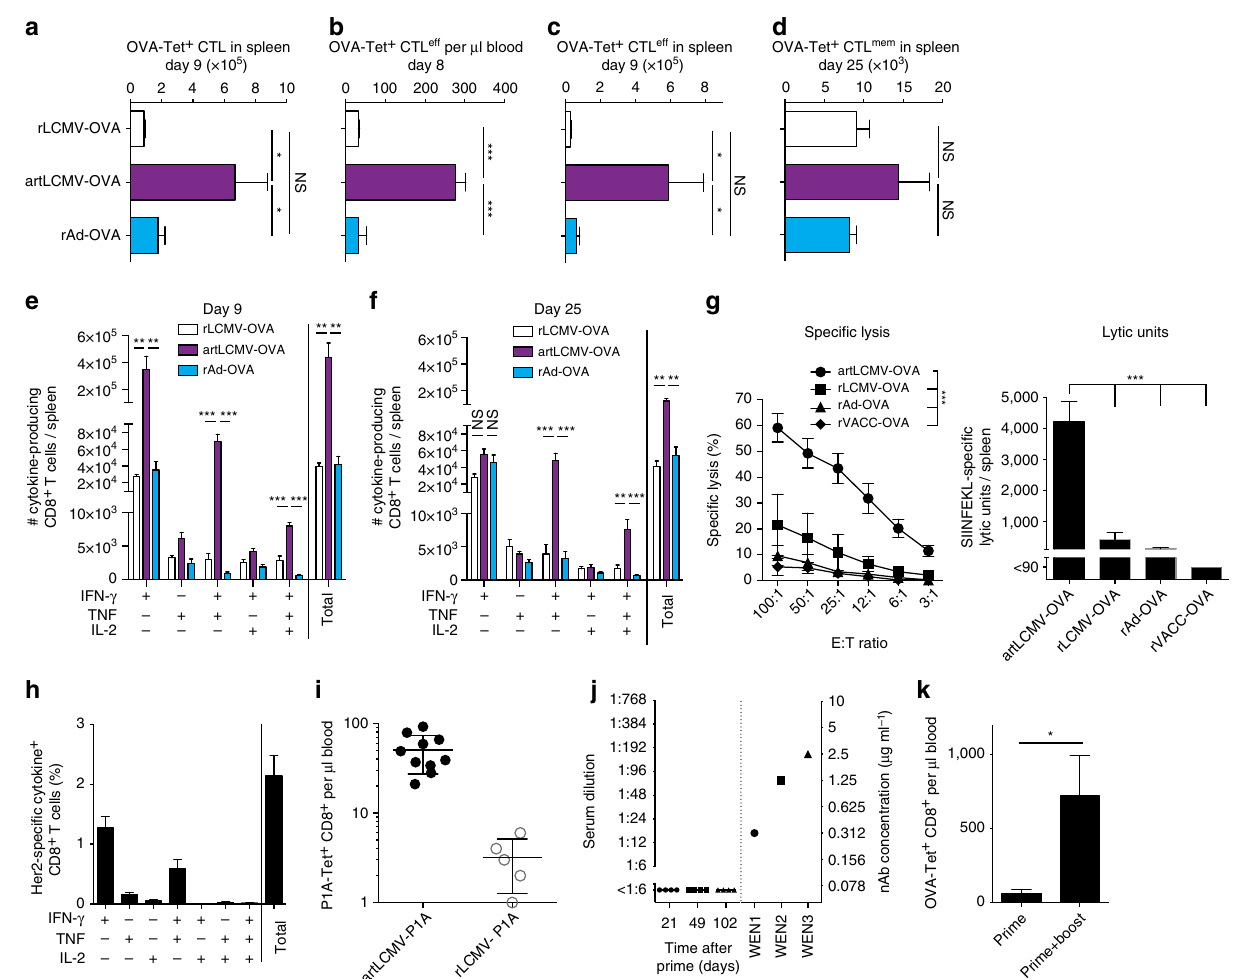
Figure 4 | artLCMV induces polyfunctional CTL eff responses against self and non-self antigens. ( a – d ) OVA-specific total CTLs, CTL eff (Klrg1 þ CD127 (cid:2) ) and memory CTL (CTL mem , Klrg1 (cid:2) CD127 þ ) in blood (d8; b ) and spleen ( a , c , d ) upon immunization with artLCMV-OVA, rLCMV-OVA or rAd-OVA. Bars represent the mean þ s.e.m. ( n ¼ 4). N ¼ 2. ( e , f ) Polyfunctional OVA-specific CTLs in spleen after artLCMV-OVA, rLCMV-OVA or rAd-OVA immunization. Bars represent the mean þ s.e.m. ( n ¼ 4–5). N ¼ 2. ( g ) OVA-specific primary ex vivo cytotoxicity and lytic units in spleen on d7 after artLCMV-OVA, rLCMV-OVA, rAd-OVA or rVACC-OVA vaccination. N ¼ 2. ( h ) Cytokine profile of splenic Her2-specific CTLs on d9 after artLCMV-Her2 immunization. Bars represent the mean þ s.e.m. ( n ¼ 3). N ¼ 2. ( i ) P1A-specific CTLs in blood on d14 after immunization of BALB/c mice with r3LCMV-P1A or rLCMV-P1A. Symbols represent individual mice. N ¼ 2. ( j ) Undetectable LCMV-neutralizing antibodies after artLCMV prime-boost immunization (prime d0, boost d87). WEN1, WEN2 and WEN3 were LCMV-neutralizing monoclonal antibody controls. Symbols show individual mice. N ¼ 2. ( k ) OVA-specific CTLs in blood